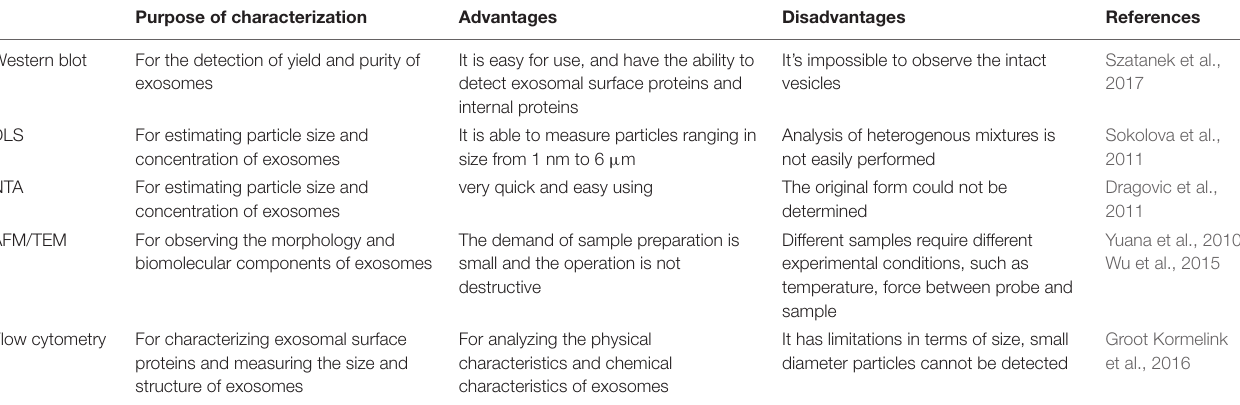
TABLE 2 | Comparison of characterization methods of